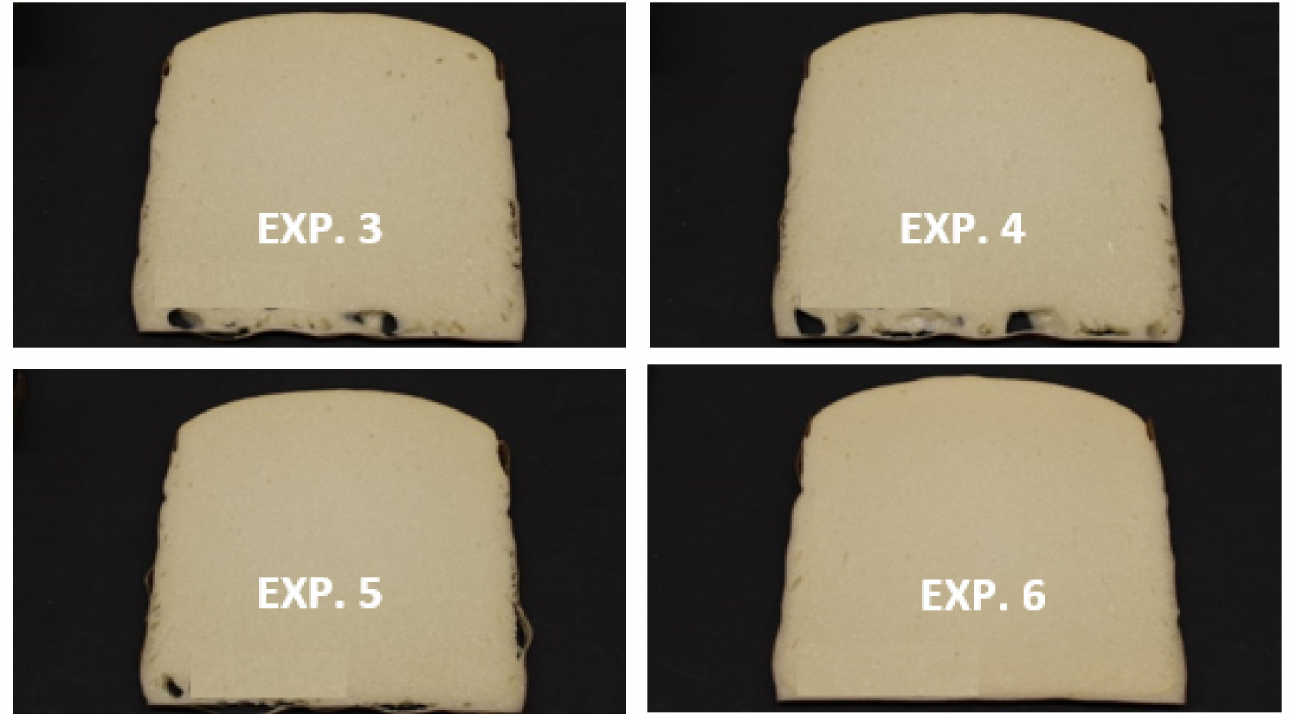
Figure 4. Optical photographs of the cross-section surfaces of the PU foams obtained with different tertiary amine catalysts, Amine 1 and Amine 2 at 1:3 ratio (Exp. 3), Amine 1 (Exp. 4), Amine 2 (EXP. 5) and Amine 3 (EXP. 6), at 70:30 reference polyol:Repolyol ratio, using the formulations presented in Table